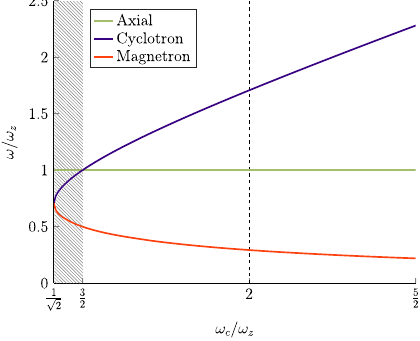
FIG. 2. Frequencies of oscillation of a single-ion Penning trap as a function of the bare cyclotron frequency. All frequencies are given in units of the axial